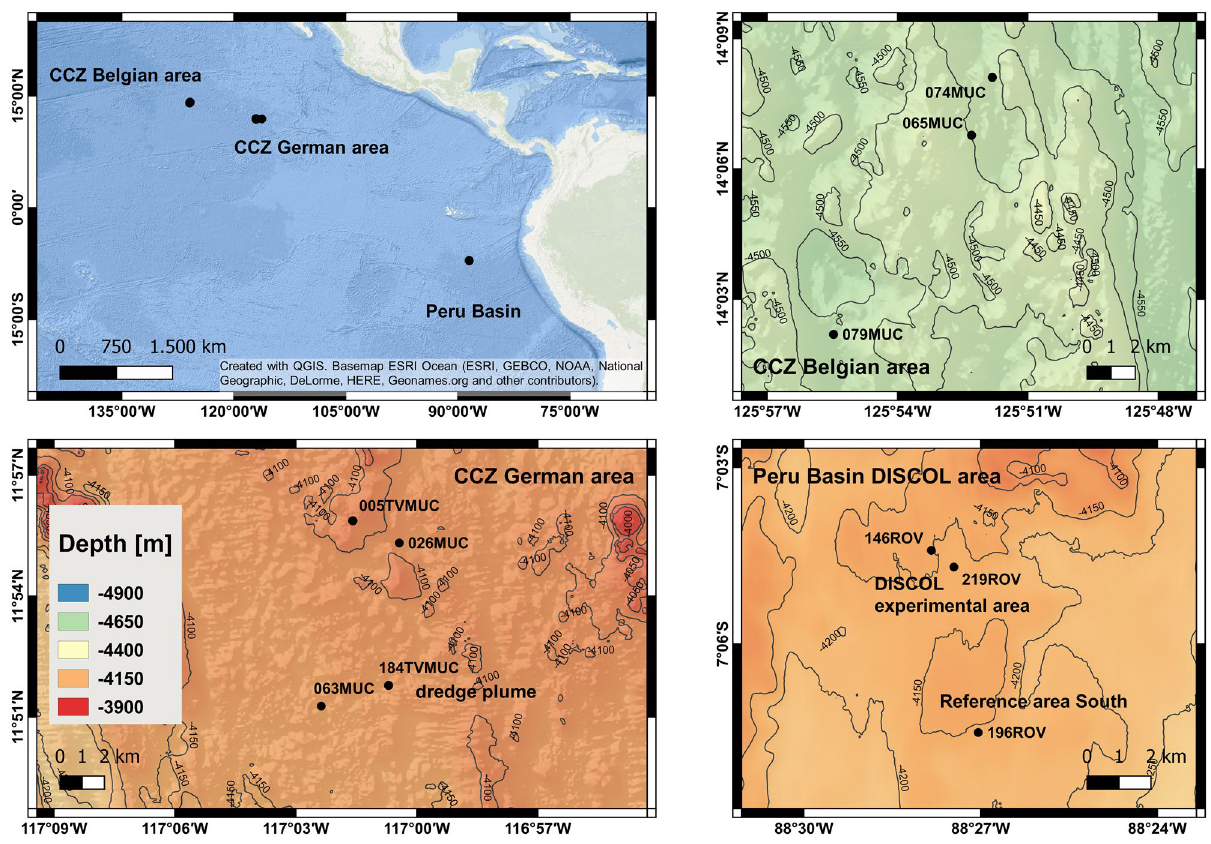
Figure 1. Sampling locations in the Belgian (top right) and German (bottom left) license areas for polymetallic nodule mining in the CCZ and in the DISCOL area in the Peru Basin (bottom right). 149MUC is not